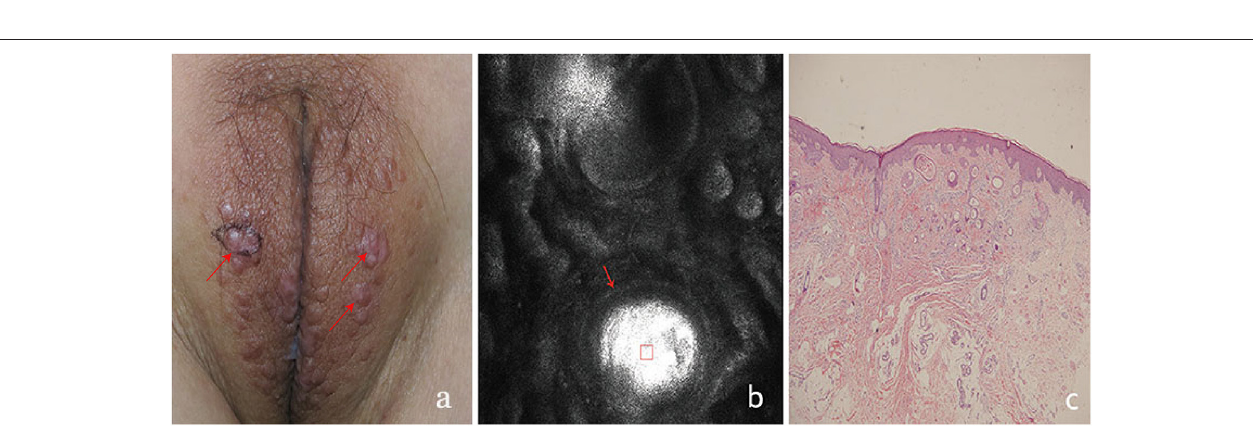
FIGURE 1 | The clinical presentation, RCM findings and histology of vulva syringoma (case 1). (a) , the clinical image of case 1, (b) , the RCM image findings; (c) , the histology findings. The presence of round to oval high refractive, and relatively monomorphous mass of varing sizes (the red square)was prensent in the superficial dermis, with 1–2 layers of surrounding light-dark line structure (red arrowhead) in (b) .